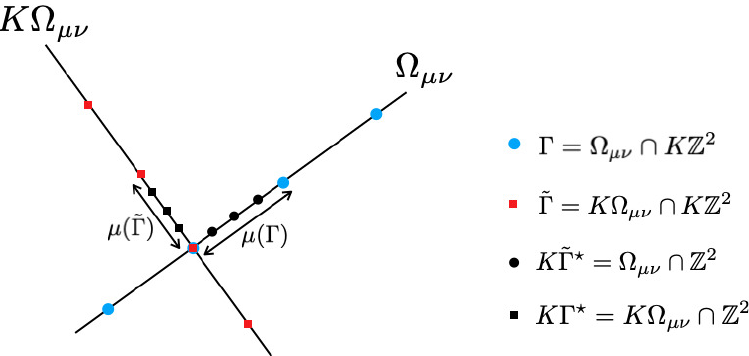
Figure 3 . K (cid:10) (cid:22)(cid:23) and (cid:10) (cid:22)(cid:23) are invariant subspaces of AA T .